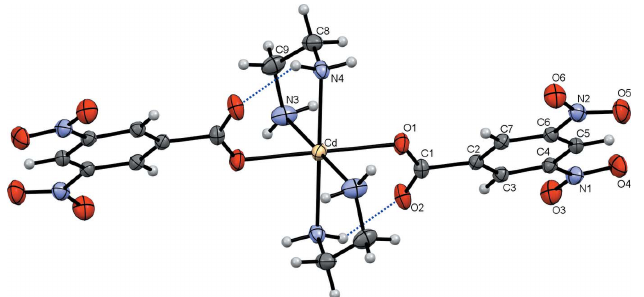
Figure 1 The molecular structure of the coordination complex [Cd(DNBA) 2 (en) 2 )] with displacement ellipsoids shown at the 30% probability level. The crystallographically independent part of the molecule is labelled, the atoms of the remaining part are generated by inversion symmetry. [Symmetry code: (i) (cid:3) x + 2, (cid:3) y + 1, (cid:3) z + 2].